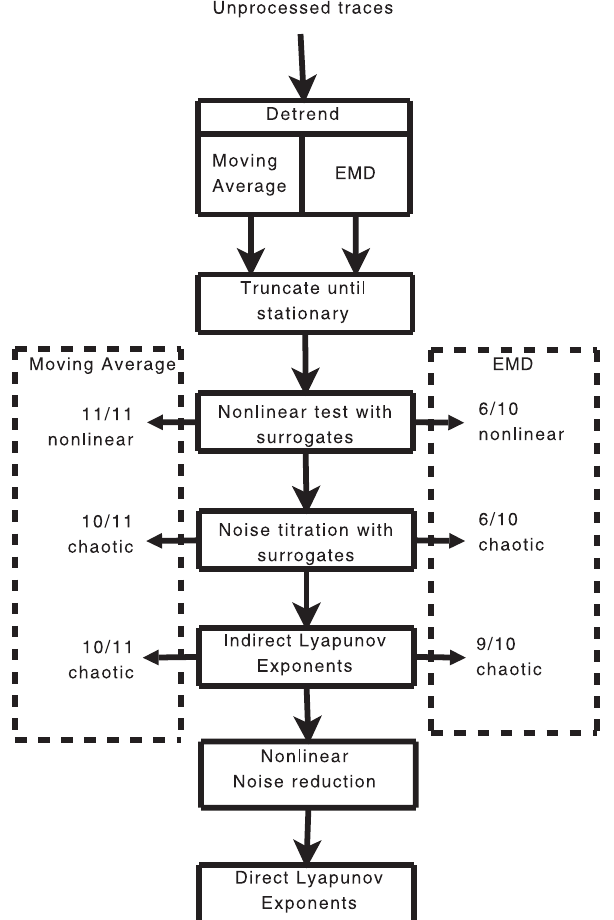
Figure 3. Flowchart of the tests run to gather evidence for chaos. A summary of results on the left of the figure are after processing with a moving average. The summary of results on the right are after detrending with Empirical Mode Decomposition (EMD).